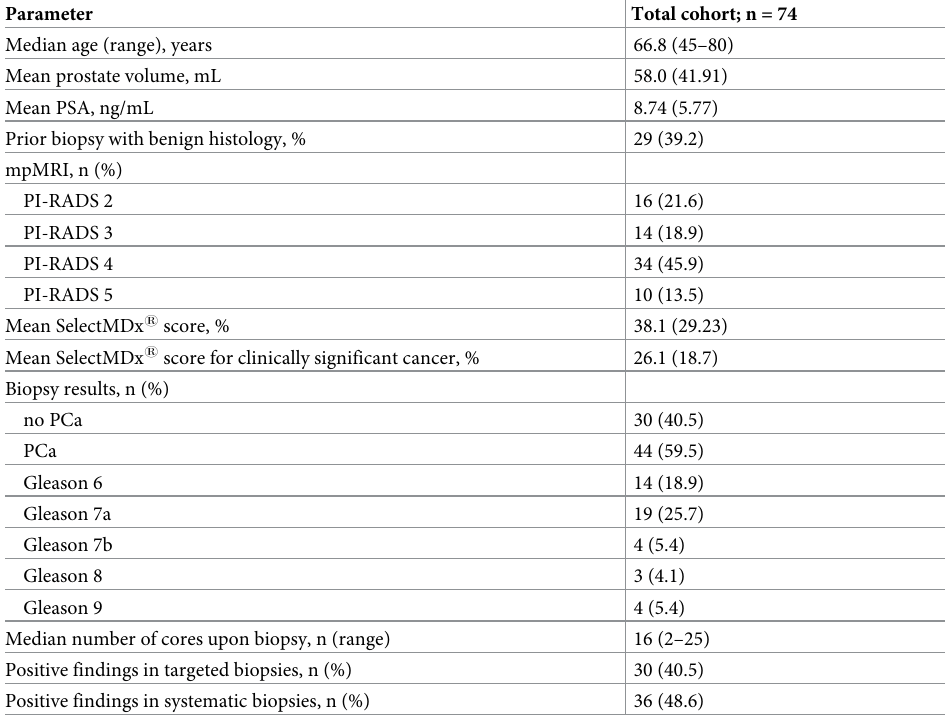
Table 1. Patient’s characteristics. Parameter Total cohort; n = 74 Median age (range), years